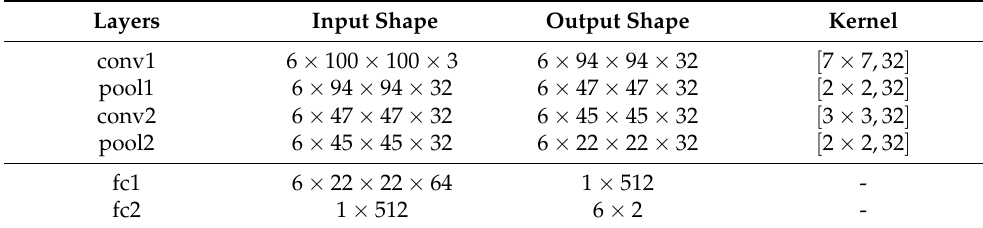
Table 1. Architecture of the lightweight network used in the patch resampling stage.